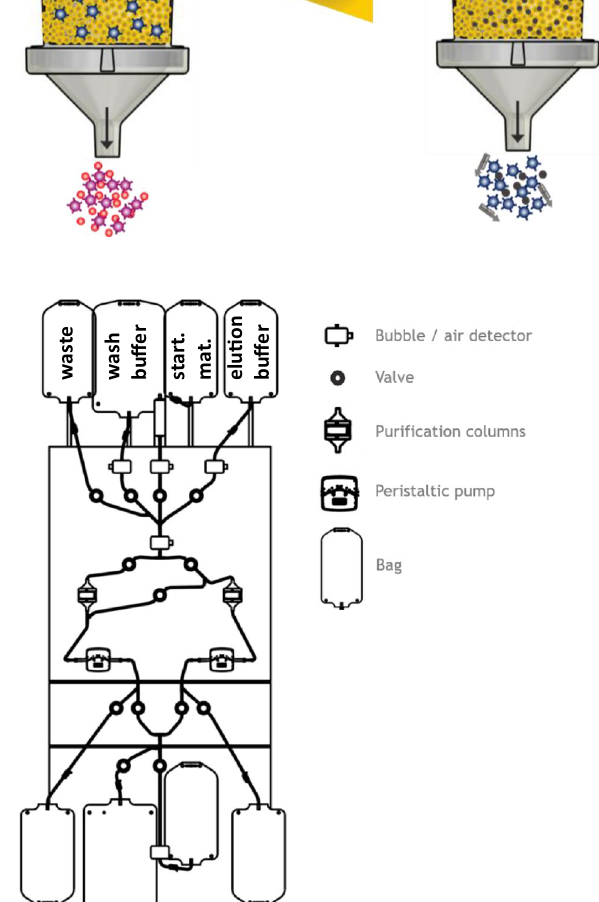
dry selection matrix at the appropriate scale; bags mounted to the bottom of the tubing set for collecting flow through/waste into one bag and eluted target cell fractions from both columns into two separate bags. All cell selection studies described here were either performed on clinical-grade pilot-devices or clinical- grade prototypes. All devices were equipped with similar hardware components and controlled by an automation system resulting in identical functionality and consistent data integration. Hardware components relevant for the purification procedure are depicted in Fig. 1B and include valves for controlling liquid flow path, peristaltic pumps for transporting all liquids at a dedicated speed, bubble detectors to control presence of liquid and column